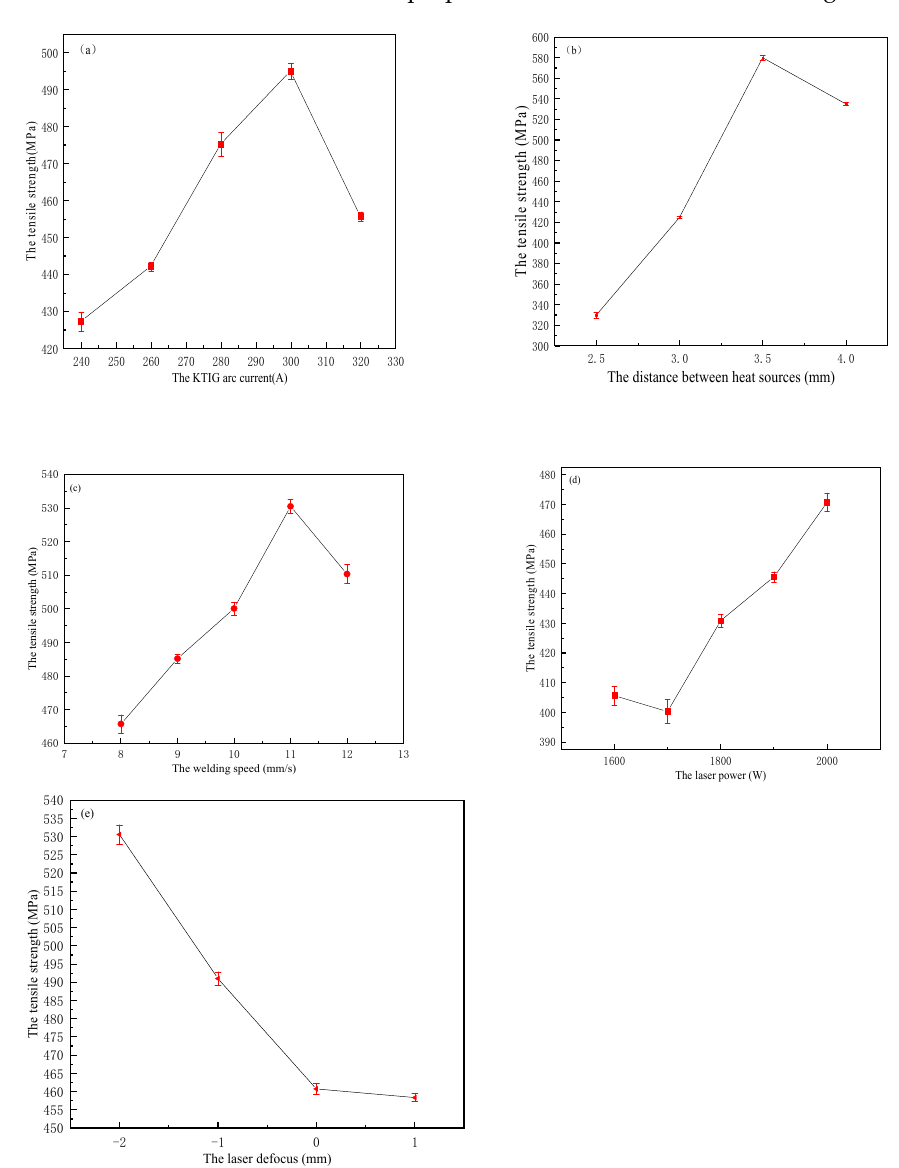
Figure 14. The tensile strength at different hybrid welding parameters: ( a ) the K-TIG arc current, ( b ) the distance between heat sources, ( c ) the welding speed, ( d ) the laser power, ( e ) the laser defocus.